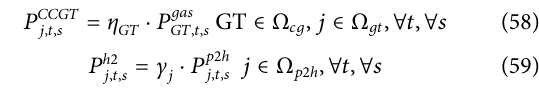
Figure 3 . P2H plays a crucial role in coupling multi-energy networks, and CCGT links the gas networks and power grid effectively.